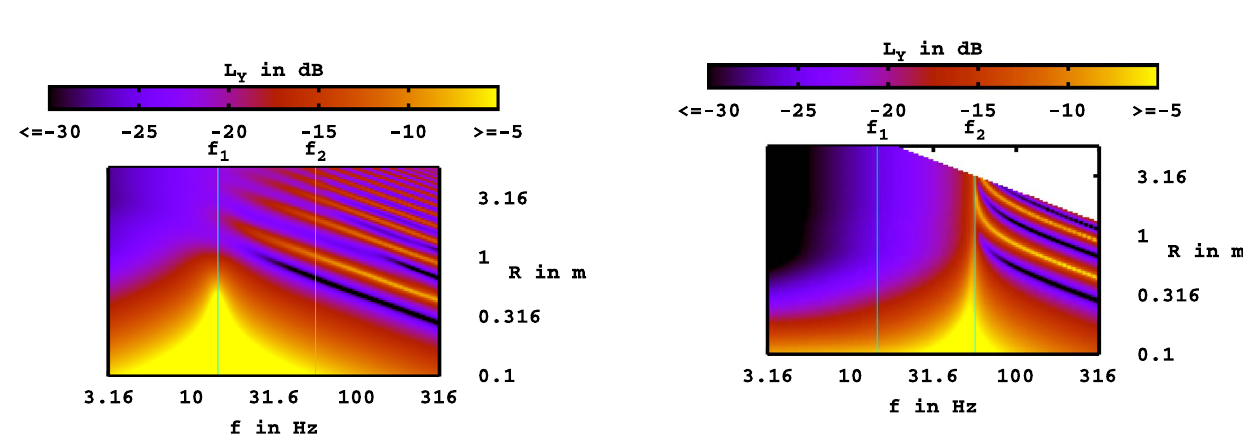
Figure 18. Level of admittance L Y according to (56); cyan marker lines for f 1 and f 2 ; r = 1.0 (cid:5) 10 3 Pa s/m 2 .